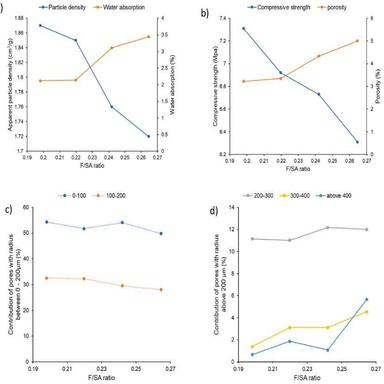
The effect of F/SA ratio on: (a) particle density and water absorption, (b) compressive strength and overall porosity, (c) percentage share of pores with equivalent radius between 0 and 200 μm, (d) percentage share of pores with equivalent radius between above 200 μm.